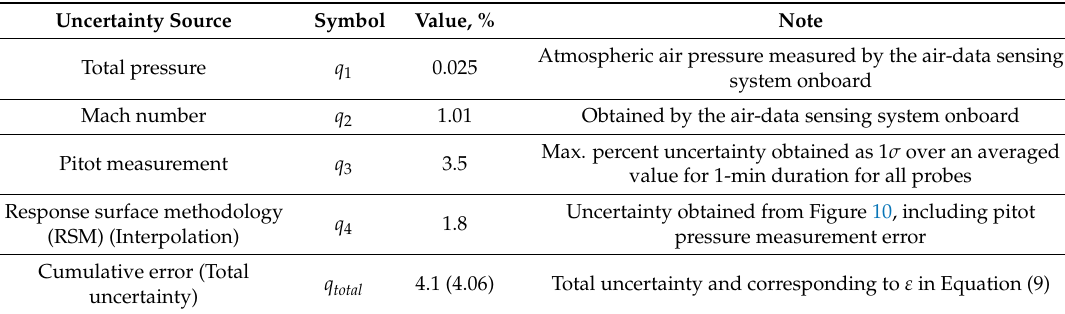
Table 1. Summary of possible uncertainty